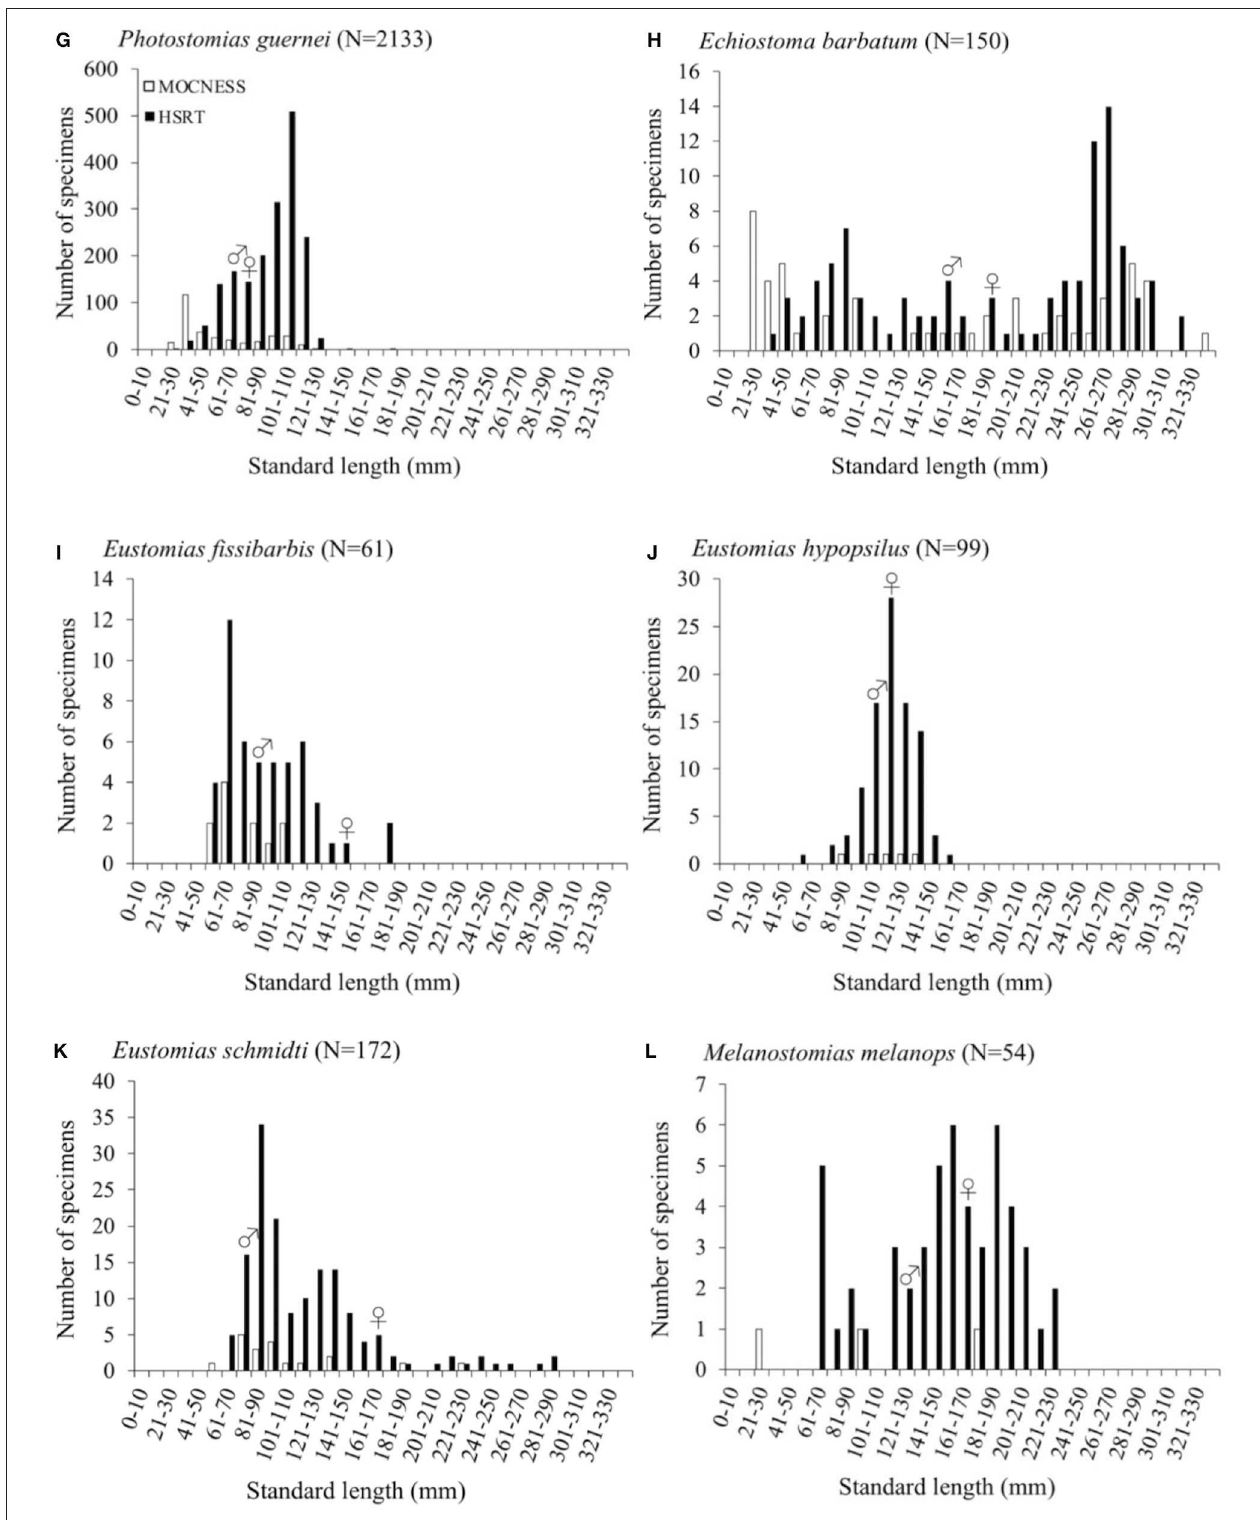
FIGURE 5 | Size distributions as a function of gear type of (A) Astronesthes atlanticus , (B) Astronesthes richardsoni , (C) Astronesthes similus , (D) Chauliodus sloani , (E) Aristostomias xenostoma , (F) Malacosteus niger , (G) Photostomias guernei , (H) Echiostoma barbatum , (I) Eustomias fissibarbis , (J) Eustomias hypopsilus , (K) Eustomias schmidti , and (L) Melanostomias melanops from the northern Gulf of Mexico.